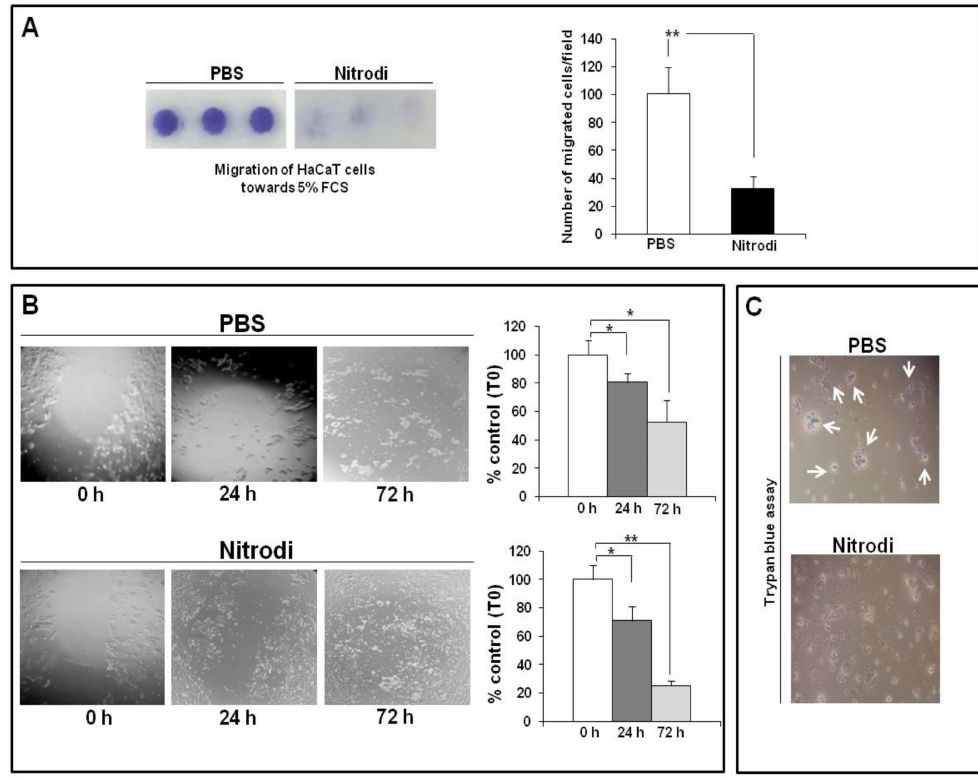
Figure 4. Effects of Nitrodi’s water on HaCaT cell migration. ( A ) Effects of PBS and Nitrodi on HaCaT cell chemotaxis. Cells treated with PBS (white column) and Nitrodi (black column) were allowed to migrate in response to 5% FCS for 24 h at 37 ◦ C in a humidified (5% CO 2 ) incubator. Error bars represent standard deviation of the mean of triplicate samples within one experiment. ** p < 0.001. ( B ) Effects of Nitrodi’s water on HaCaT cell wound healing. Scratch images were acquired using inverted microscope and 4 × magnification. Data were plotted and expressed as a percentage of the length of wound size over T0 (assumed as 100%). Error bars represent standard deviation of the mean of triplicate measurements within one experiment. * p < 0.05; ** p < 0.001 ( C ) In situ Trypan blue staining of HaCaT cells. Photographs show cells treated for 72 h with PBS and Nitrodi’s water. The images were acquired using inverted microscope and 10 × magnification. The arrows indicate the unviable